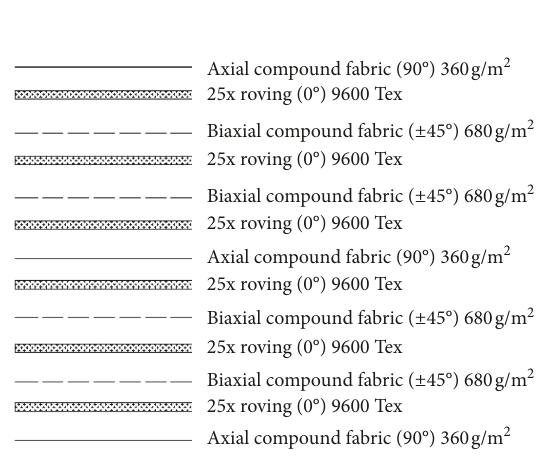
Figure 1: Laminate layup.